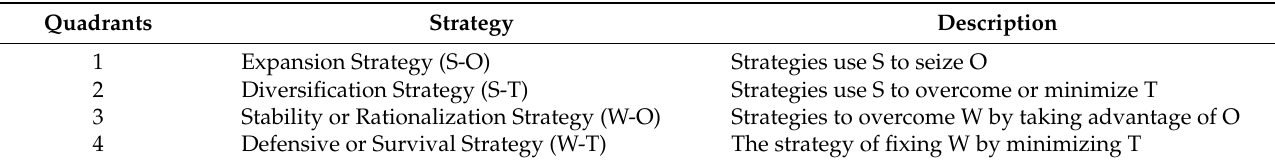
Table 1. SWOT strategy